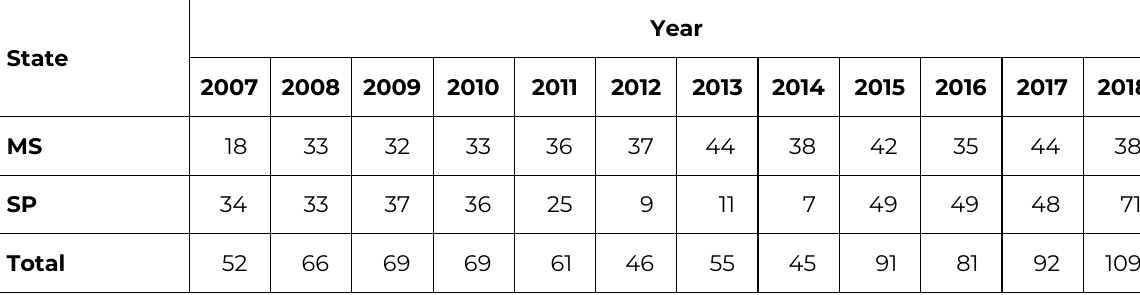
Table 6. Use of indigenous specific didactic